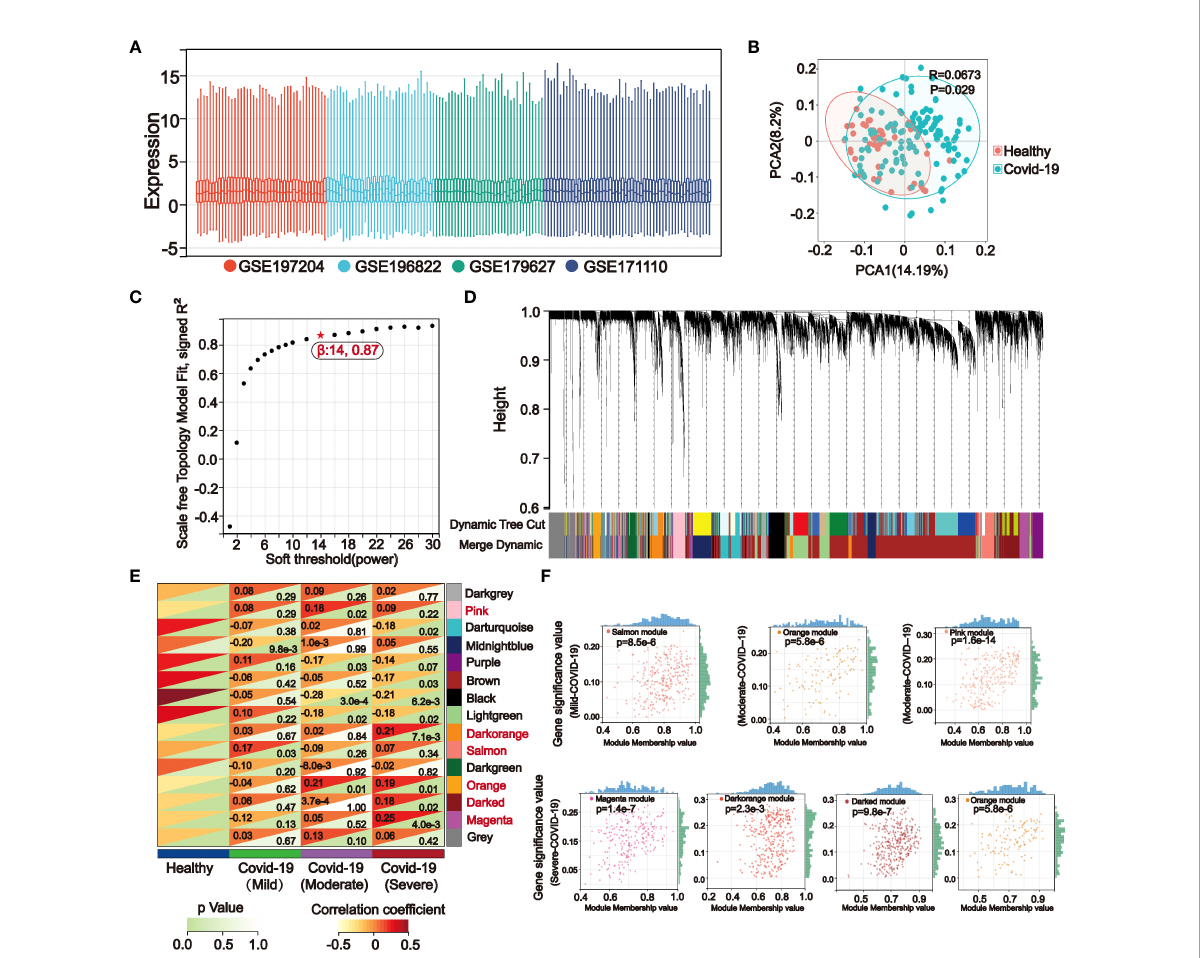
FIGURE 2 The weighted gene co-expression network (WGCNA) identi fi es key genes in mild, moderate, and severe COVID-19 modules. (A) The boxline plot after integrating the data suggests that batch effects between different datasets were removed. (B) Principal component analysis (PCA) of the integrated dataset showed signi fi cant differences between the Healthy and COVID-19 samples ( p <0.05). (C) WGCNA analysis was performed on the integrated COVID-19 dataset, and the topological overlap matrix was constructed by calculating the optimal soft threshold. (D) Similar gene modules were merged in WGCNA by the dynamic shearing tree method. (E) Gene modules-clinical features correlation heatmap. WGCNA calculated correlation coef fi cients and p -values between clinical features and 15 gene modules, of which the gray modules were nonsigni fi cant. Modules with the p -values < 0.05 in the mild (Salmon), moderate (Pink, Orange), and severe (Magenta, Darked, Orange, Darkorange) COVID-19 were selected for subsequent analysis. (F) Correlation dotplots of gene signi fi cance (GS) value and module membership (MM) value for the selected key modules in mild, moderate, and severe COVID-19, |MM|>0.8 and |GS|>0.15 were set to fi lter COVID-19 key